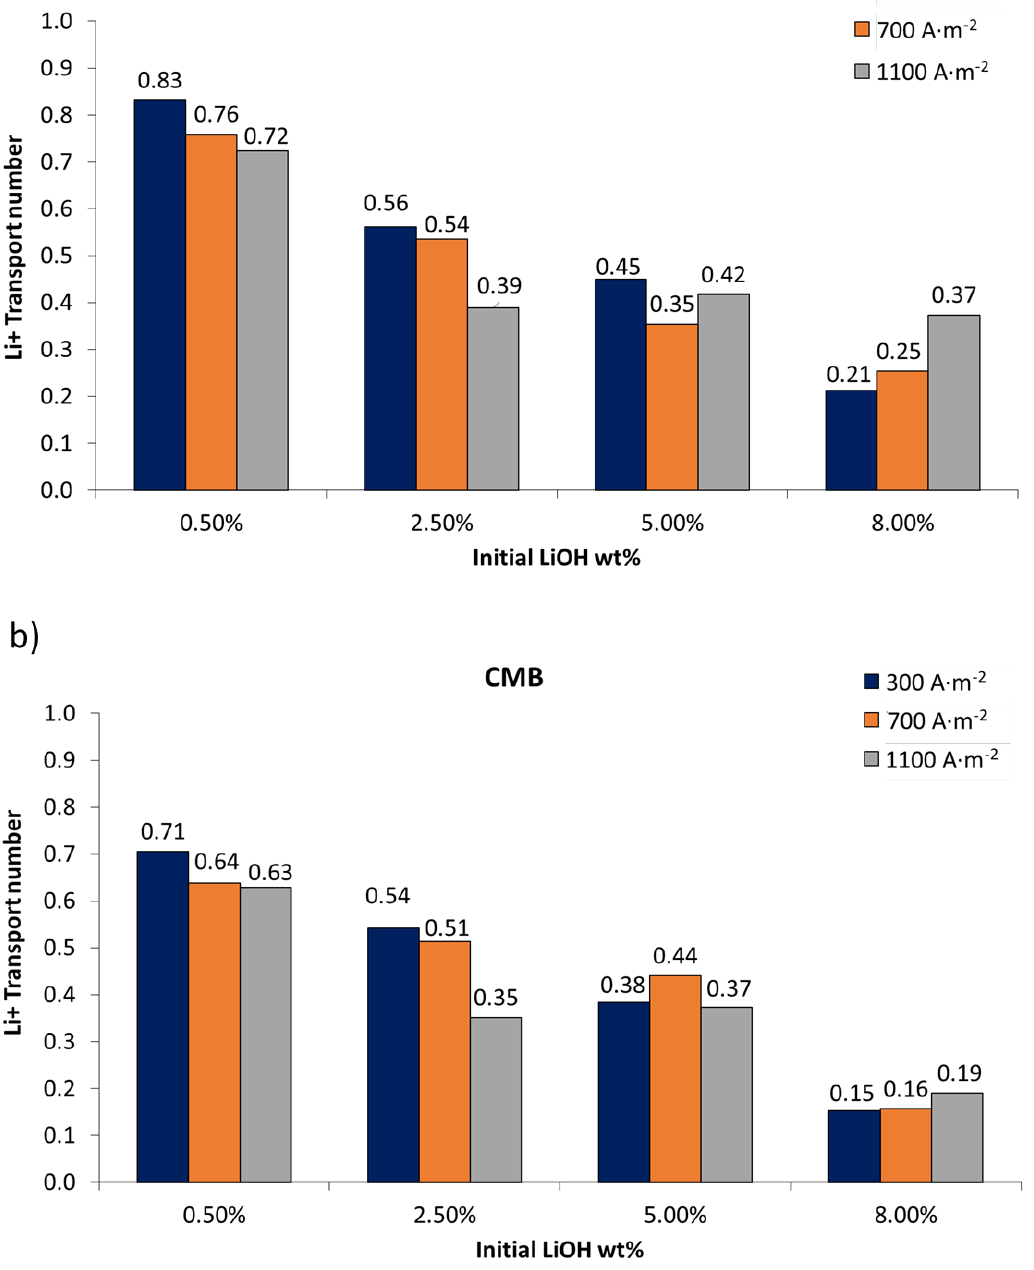
Figure 5. Lithium transport number in cation-exchange membranes according to LiOH concentration and current density (14 wt% LiCl): ( a ) CMX membrane; ( b ) CMB membrane.